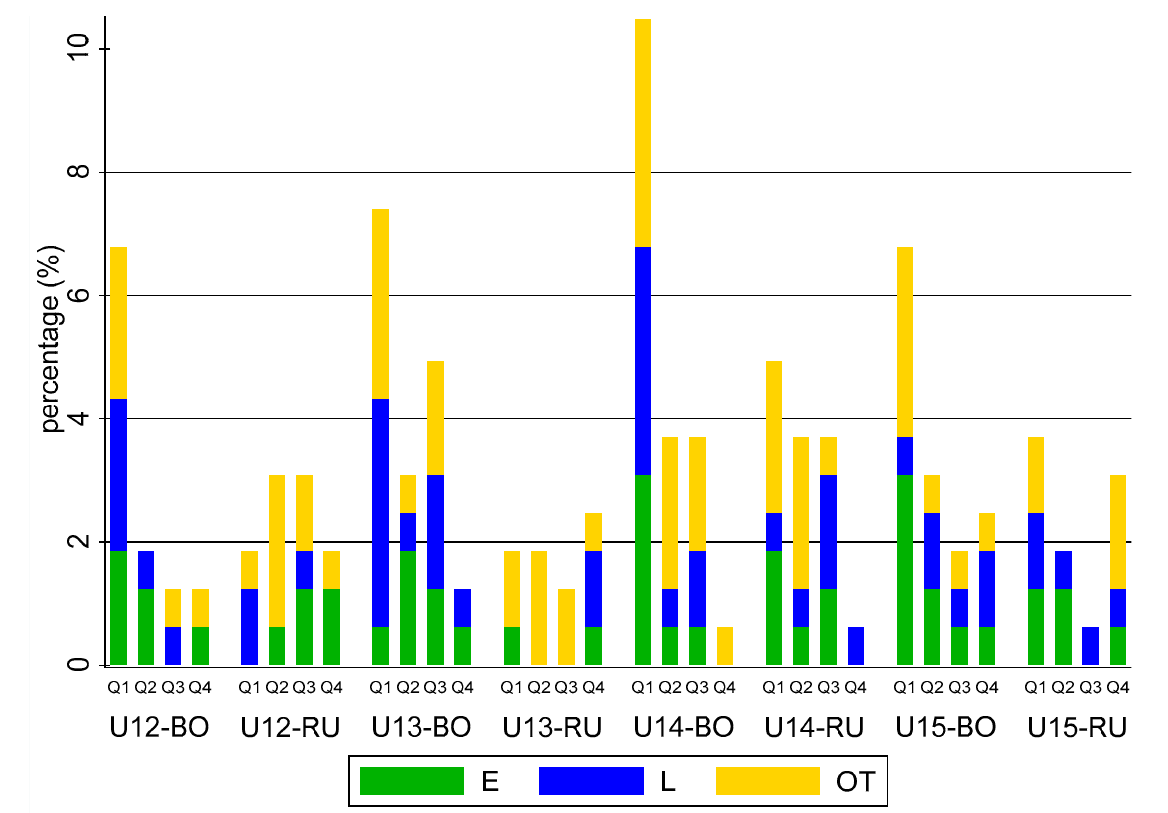
Figure 1. Percentage of soccer players for each team’s category over the maturity status and RAE